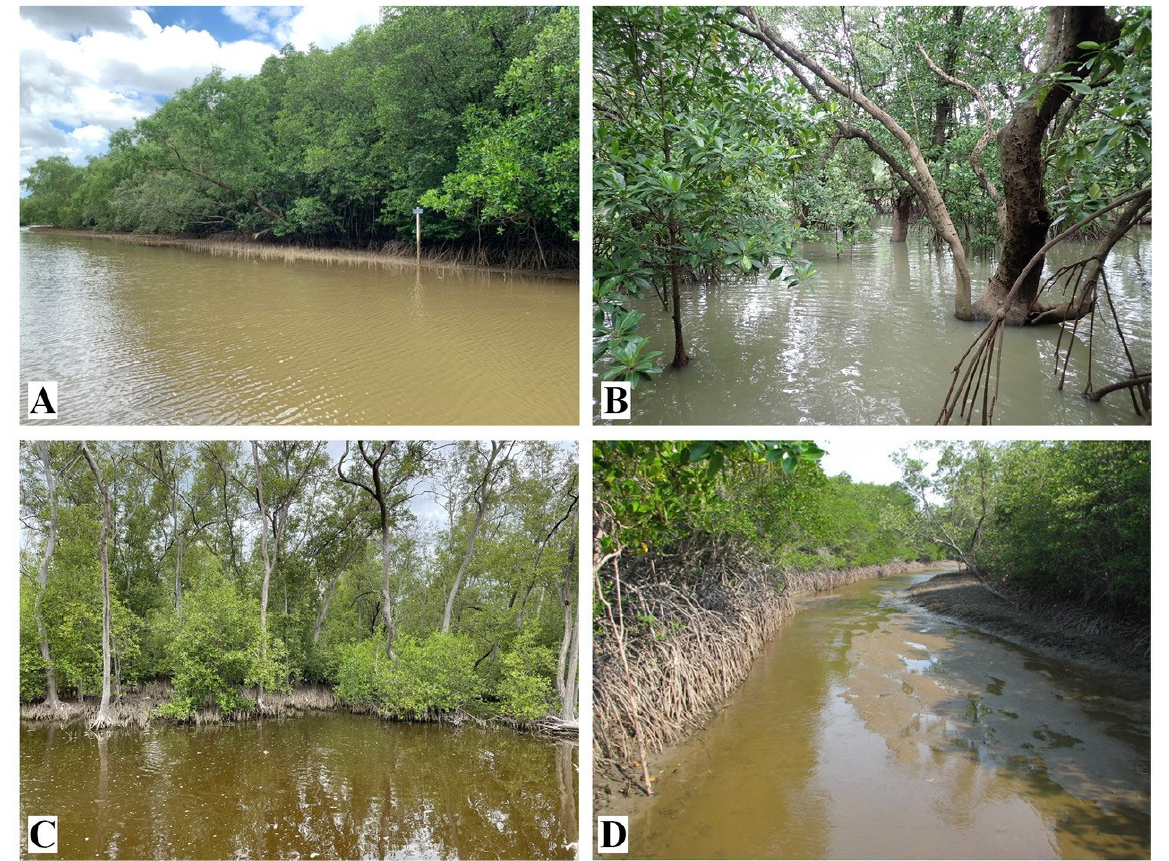
Figure 2. Photos of representative collecting sites in this study: ( A ) Ban Tha Rani (collecting site 3), ( B ) Phra Chedi Klang Nam (collecting site 13), ( C ) Chulachomklao Fort (collecting site 16), and ( D ) Pranburi Forest Park (collecting site 24). Table 1. Collection data of samples in this study.